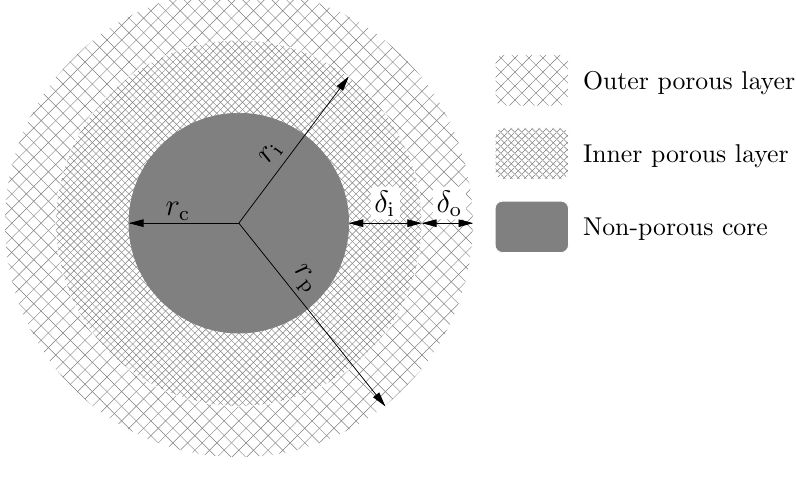
Figure 1. Structure of the bi-layer core-shell